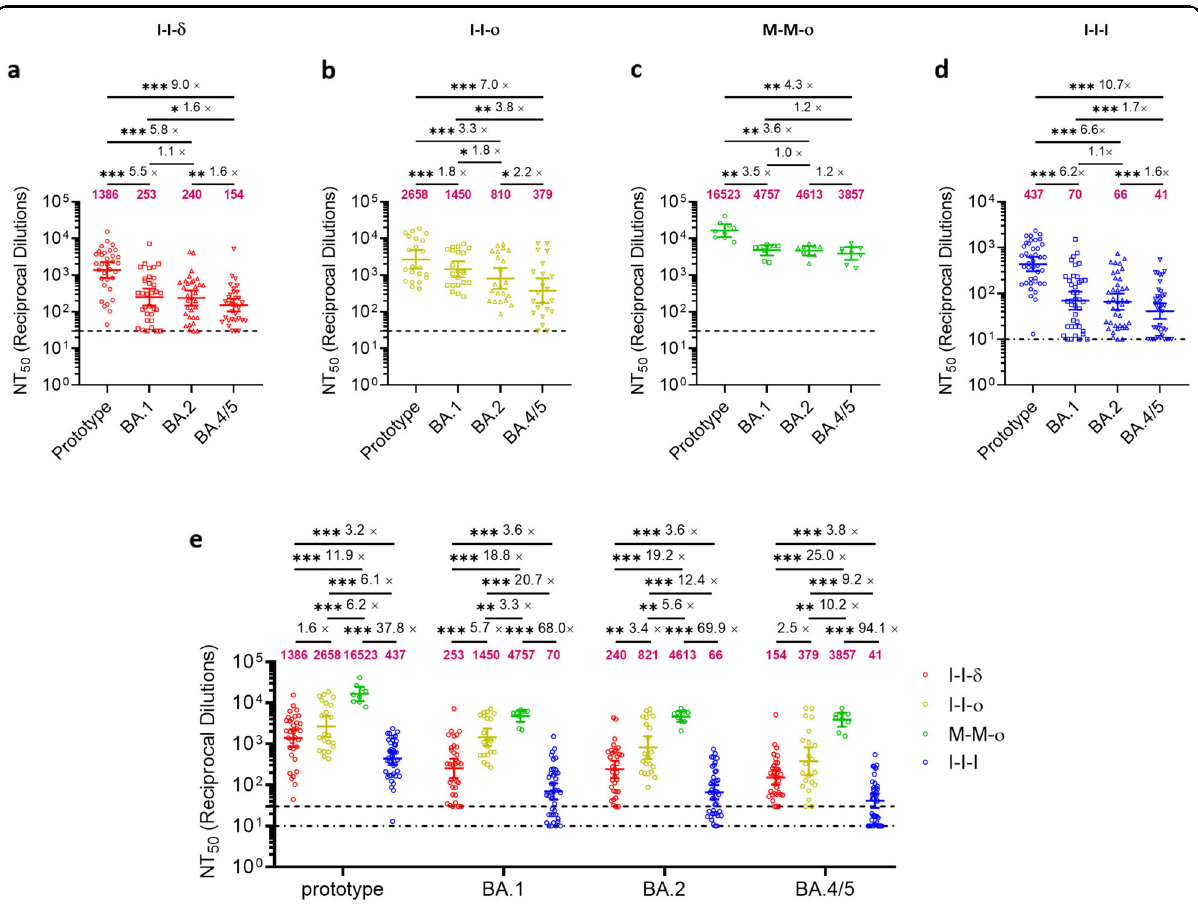
Fig. 2 The pseudovirus NAb titer against prototype, BA.1, BA.2 and BA.4/5. a – d Plasma from I-I- δ ( n = 33), I-I-o ( n = 22), M-M-o ( n = 9) and I-I-I ( n = 40) groups were assessed for pseudovirus NAb titers. e Comparison of NAb titers against prototype, BA.1, BA.2 and BA.4/5 among 4 groups. Geometric mean NT 50 values and fold change were displayed at the top of plots; bars represented geometric mean ± 95% con fi dence interval (CI), and signi fi cance relative to each Pseudovirus was determined by Wilcoxon rank-sum test. * P < 0.05, ** P < 0.01, *** P < 0.001. Dash line in a – c means that the limit of detection (LOD) of NT 50 in I-I- δ , I-I-o, M-M-o groups was 30; dash-dotted line in d means that the LOD of NT 50 in I-I-I group was